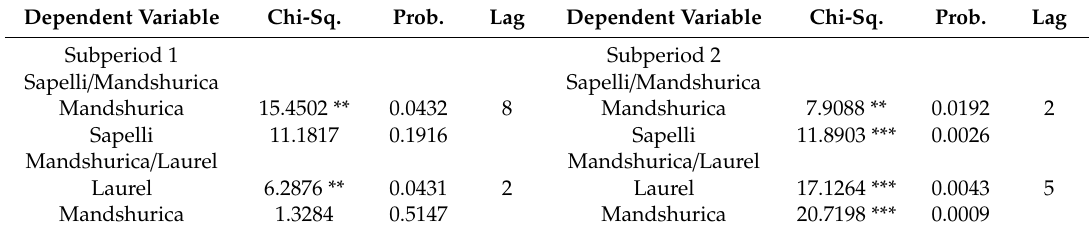
Table 4. Causality test results.